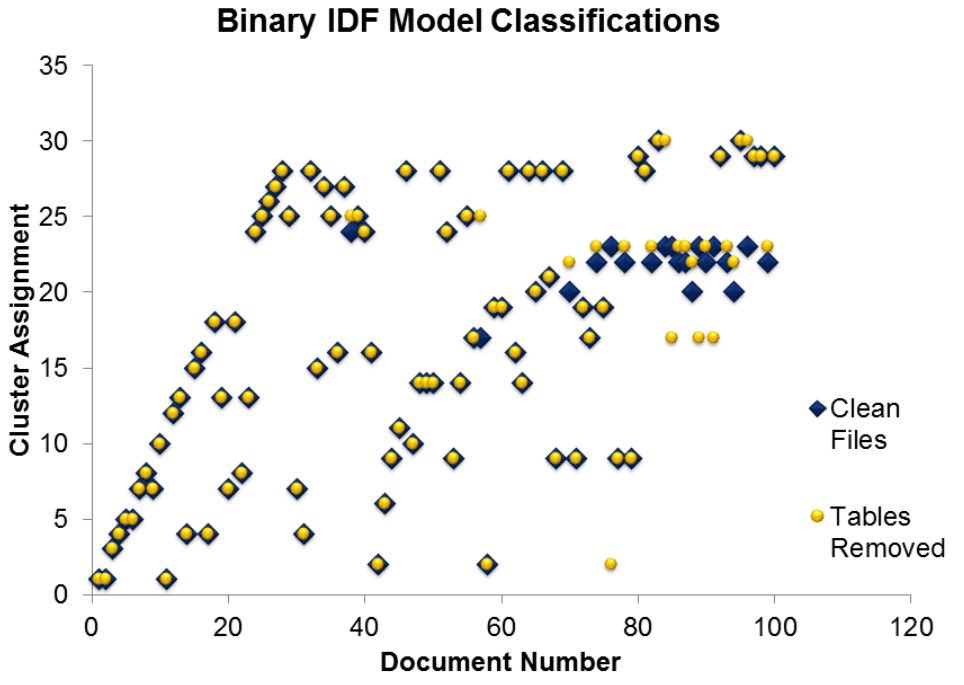
Figure 5. Scatter plot showing cluster assignments of Figure 4 by document